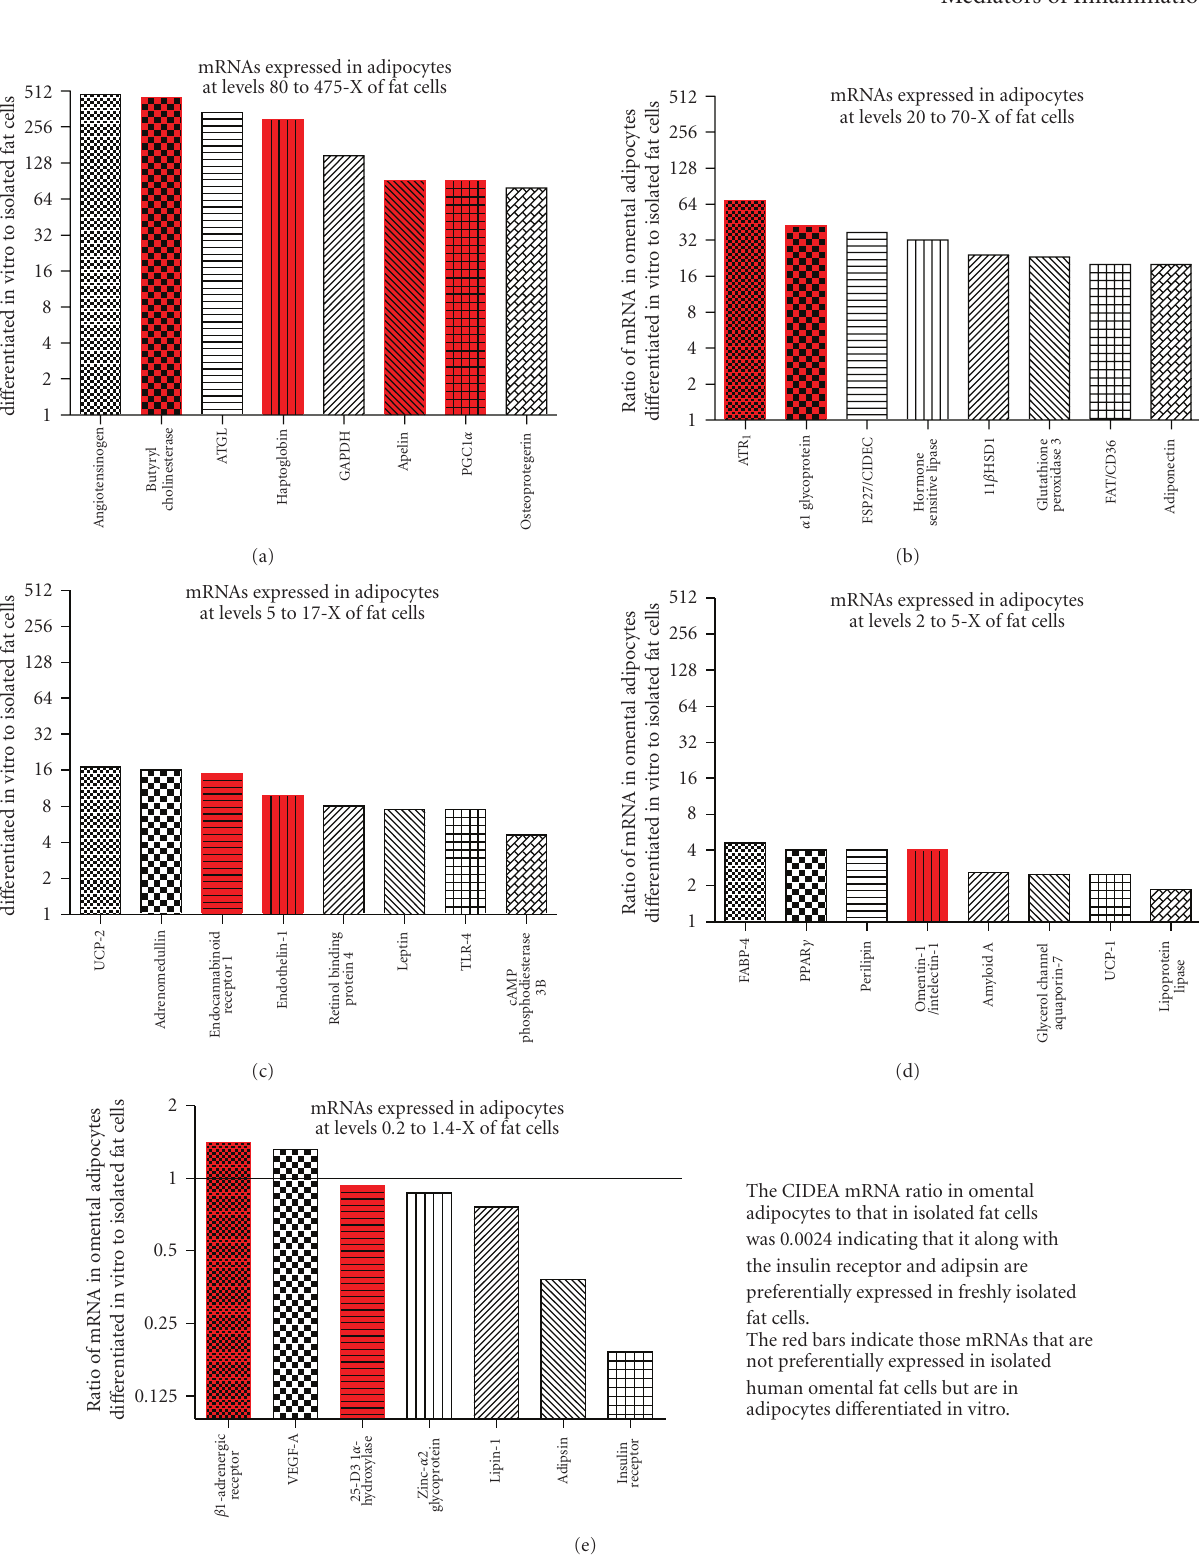
Figure 2: Comparison of mRNA expression in isolated omental fat cells versus in vitro di ff erentiated adipocytes. The data are shown as the ratio of mRNA in human omental adipocytes, di ff erentiated in vitro from the nonfat cells isolated from omental adipose tissue, to that in freshly isolated fat cells obtained by collagenase digestion of omental adipose tissue from female bariatric surgery patients. The ratios were derived from the Cp values and plotted on a log 2 scale. Comparable amounts of total RNA were used for the mRNA analyses. The Cp values from which the ratios were determined for fat cells were calculated from the data shown in Table 2 and for in vitro di ff erentiated adipocytes from Fain et al. [82, 83] or unpublished data. The red bars are for mRNAs whose expression in isolated fat cells was either the same or lower than in isolated nonfat